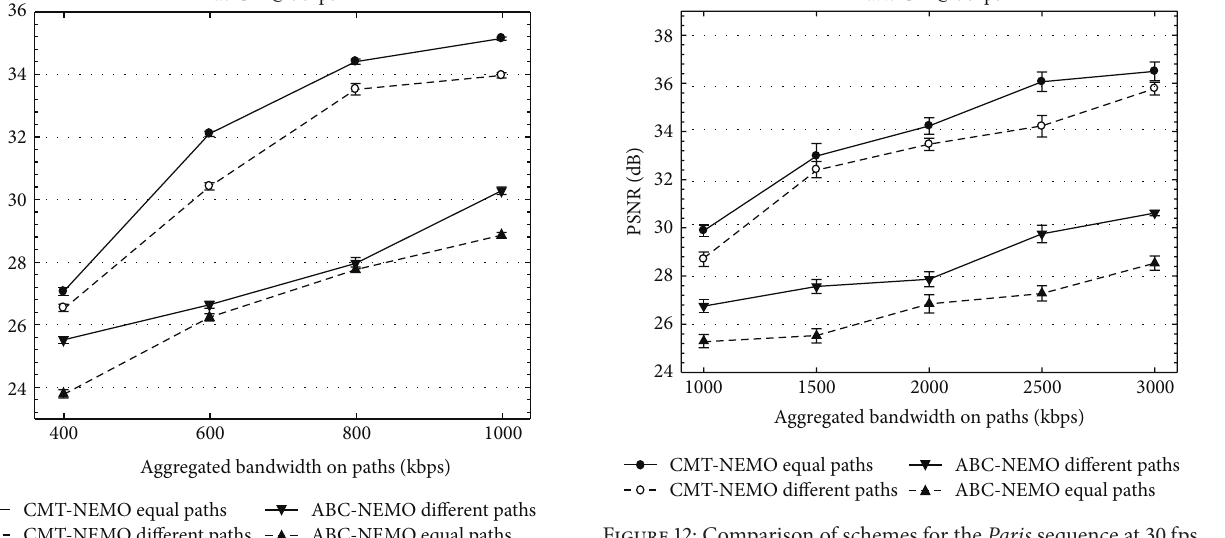
Figure 12: Comparison of schemes for the Paris sequence at 30fps.